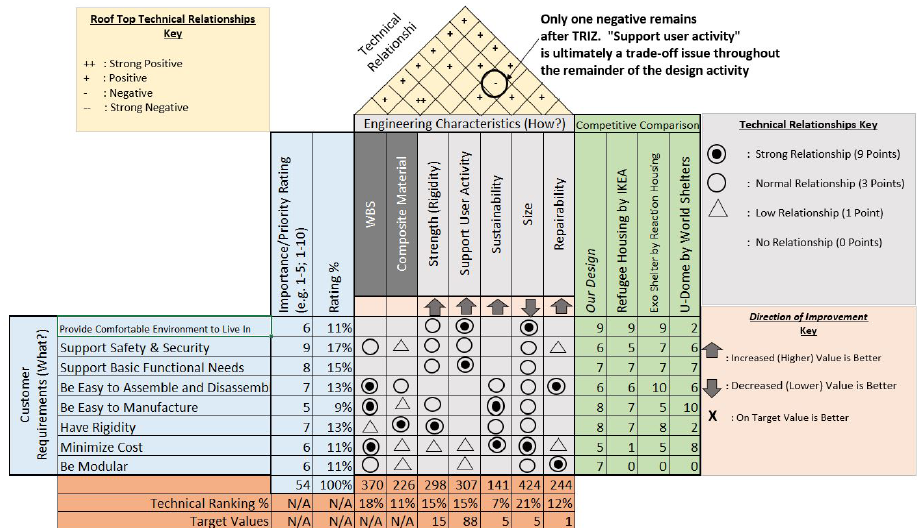
Figure 16. QFD/HOQ (Initial HOQ2) Analysis of Engineering Characteristics to Customer Require- ments after resolving